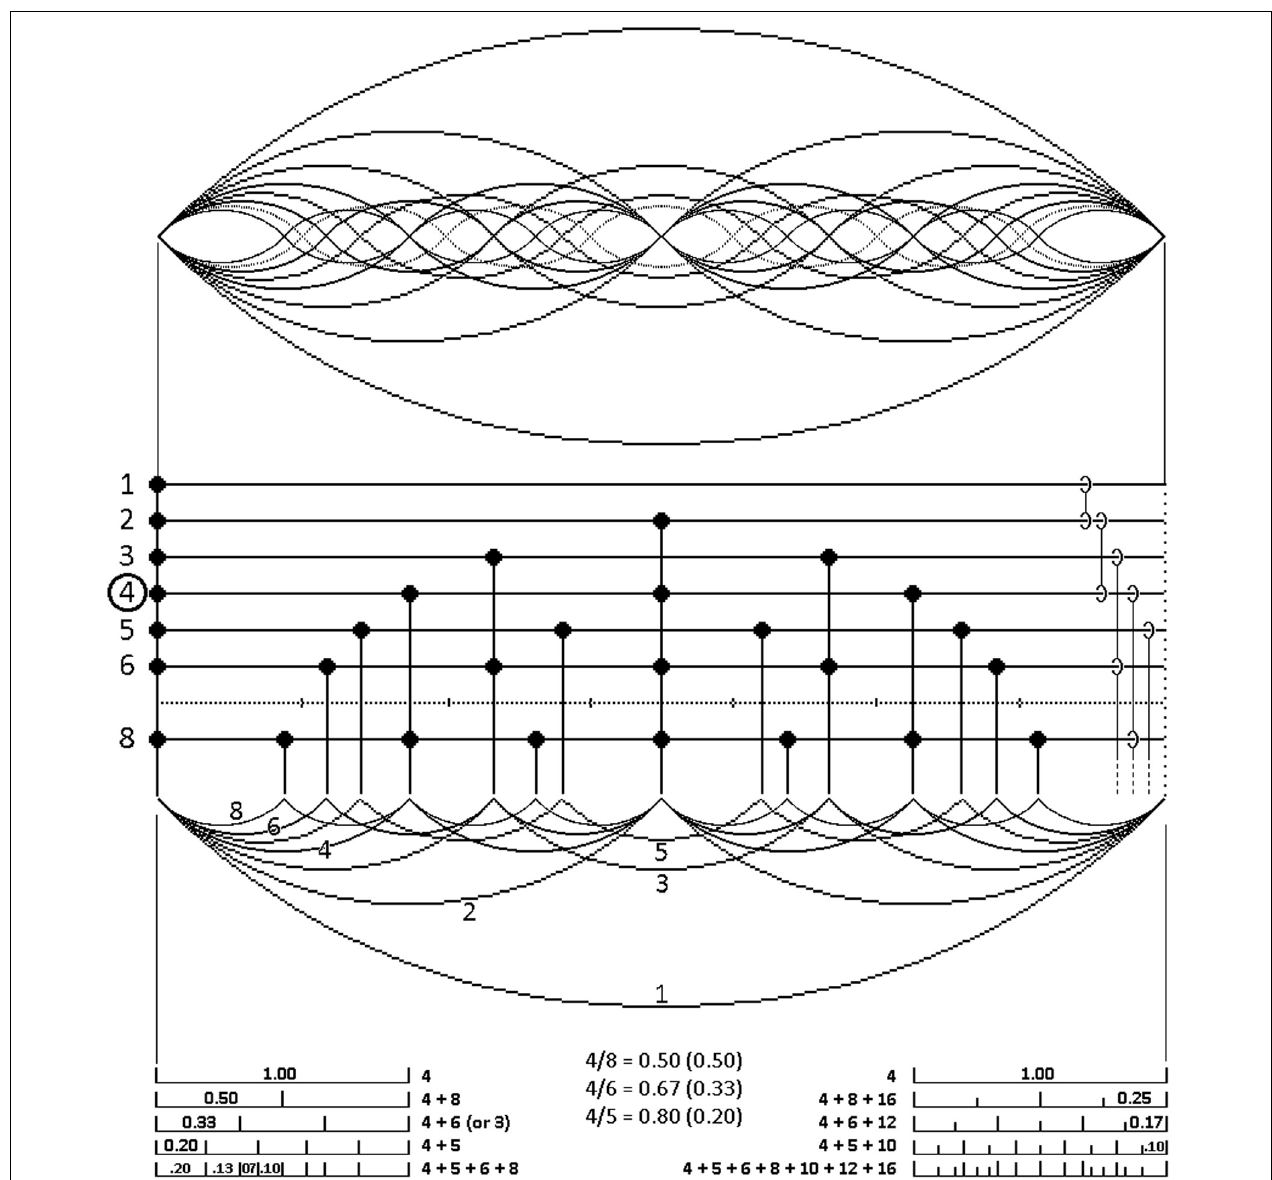
FIGURE 1 | The first eight harmonic vibrational modes of a string, displayed in their entirety in the top part of the figure (where the seventh harmonic is rendered by a dotted line). Split along its zero-crossings, half of this set of nested sine waves appears beneath the intervening grid, showing how sine wave zero-crossings yield a corresponding set of isochronous point processes. Time cycles from left to right. Omitting the seventh harmonic (see text) makes the contents of the